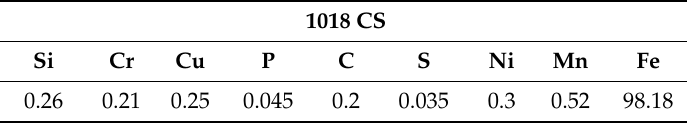
Table 1. Composition elbow material (wt.%).